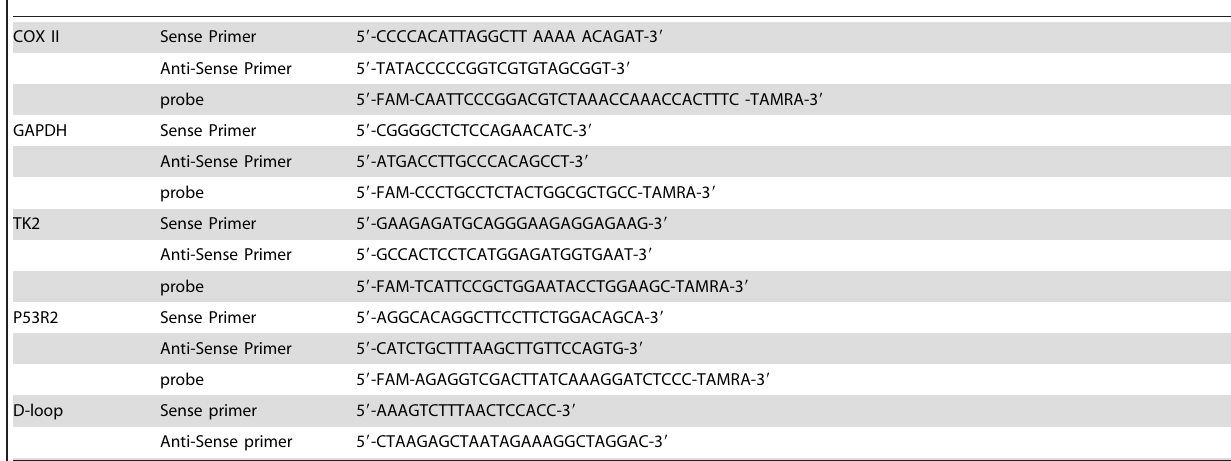
Table 1. Primers and probes for real-time qPCR and D-loop PCR.